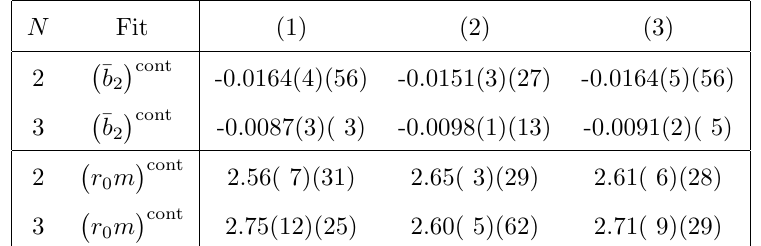
(cid:0) (cid:22) (cid:1) cont (cid:0) (cid:1) cont b 2 and r 0 m from (cid:12)ts (1) to (3) (see text). The (cid:12)rst error is the